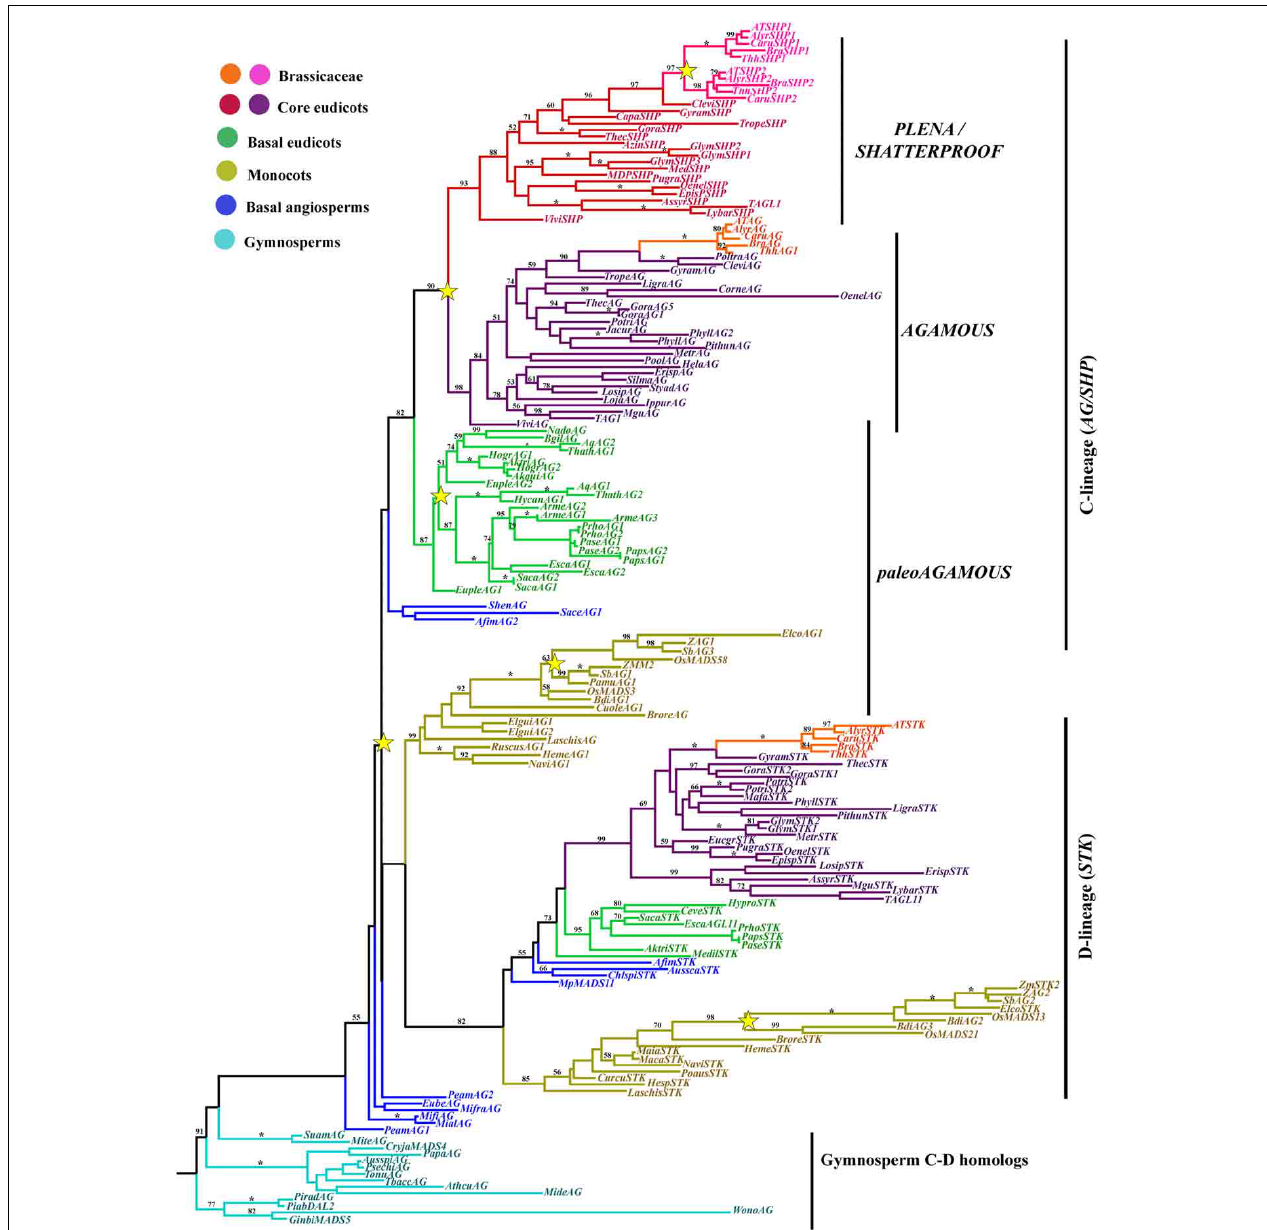
FIGURE 5 | ML tree of AGAMOUS/SEEDSTICK genes in seed plants showing a number of duplication events (yellow stars). A duplication coincident with the diversification of the angiosperms, resulting in the D-lineage and the C-lineage clades (also known as AGL11 and AG lineage, respectively). The D-lineage underwent a duplication in Poaceae but for the most part has been kept as single copy in angiosperms (see text for exceptions). The C-lineage duplicated